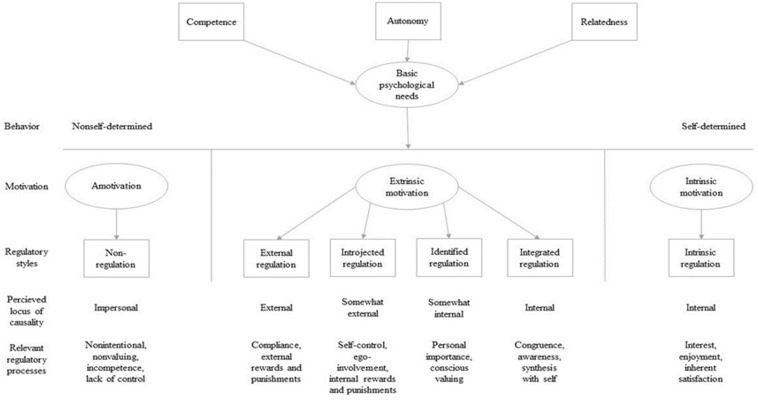
A taxonomy of human motivation, presented on a continuum, ranging from no motivation to controlled and a more autonomous form of motivation. The satisfaction of basic psychological needs forms a more autonomous motivation. The figure add the basic psychology needs to the Ryan and Deci (2000a,b) taxonomy of human motivation.